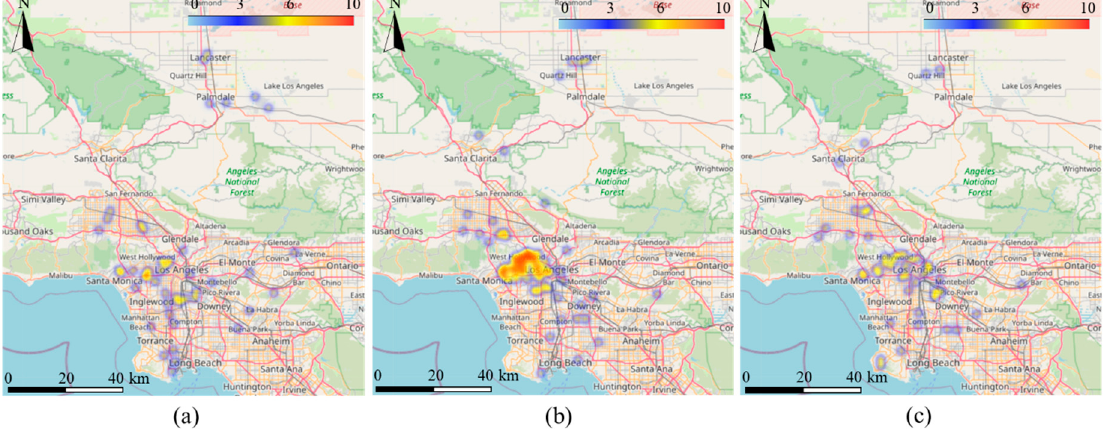
Figure 7. Hotspots of burglary in Los Angeles County, CA ( a ) 23 May 2020; ( b ) 30 May 2020; ( c ) 6 June 2020.